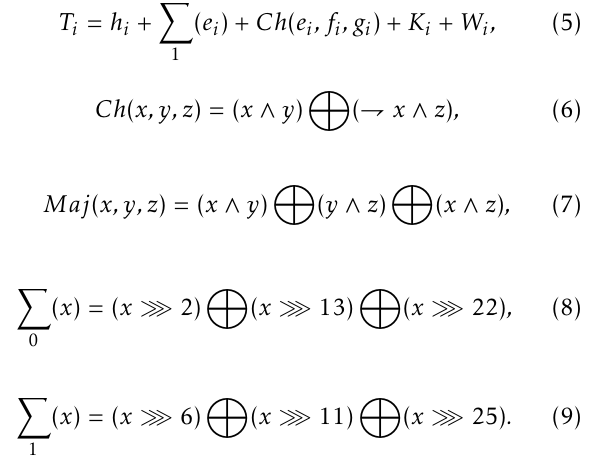
Figure 8. WSNs use blockchain technology The blocks in the chain are linked together as shown in Figure 9. Fields like previous hash, current hash are all contained in a block. The codes generated by hash functions are very long strings of words, but